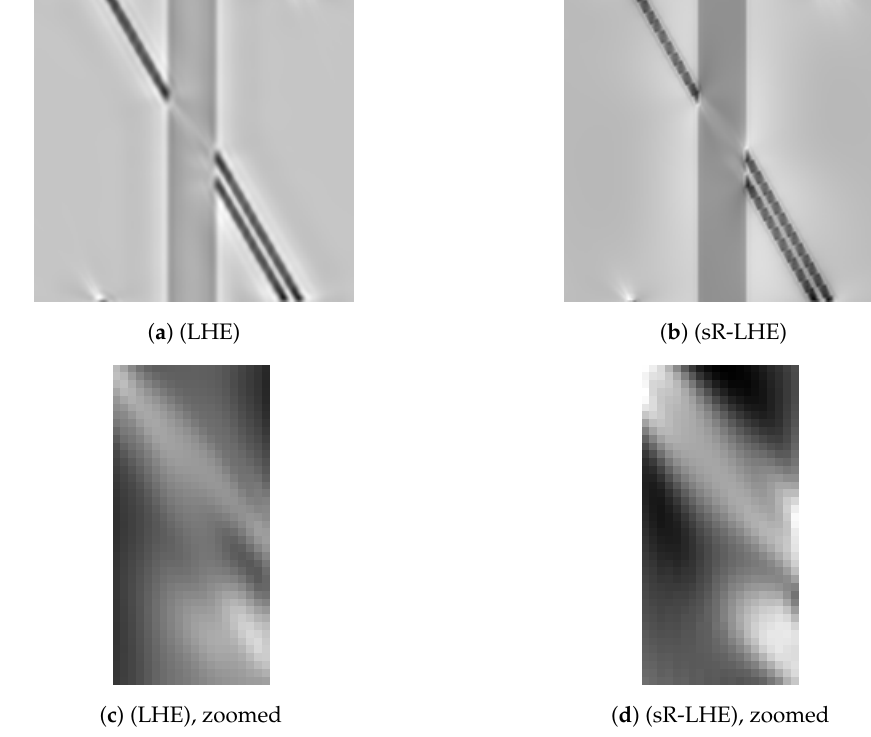
Figure 7. Model output for Poggendorff illusion in Figure 3a via LHE models. ( a ) result of the LHE model proposed in [44,45] (with parameters σ µ = 2, σ ω = 12, λ = 0.7, α = 5). ( b ) result of (sR-LHE) with parameters α = 8, τ = 2.5, λ = 0.5, σ µ = 2.5, ∆ t = 0.15, ∆ τ = 0.1. ( d ) (resp. Figure 7c): zoom and renormalization on [ 0,1 ] of the central region of the result in ( b ) (resp. Figure